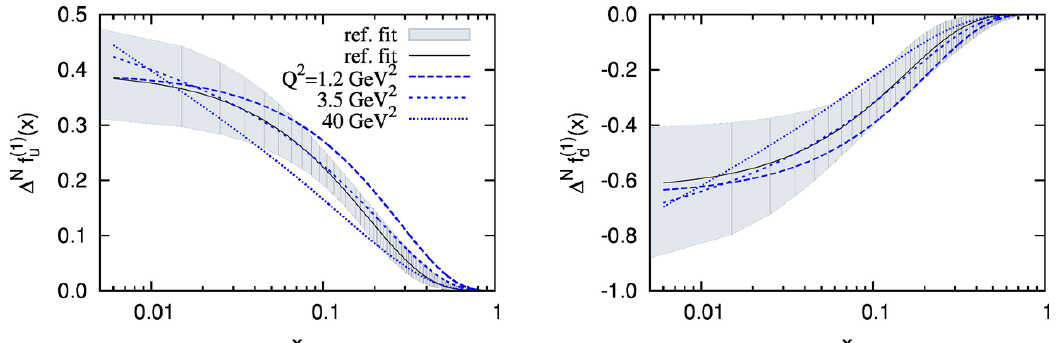
Figure 11 . Extracted (cid:12)rst moments of the Sivers function for u = u v +(cid:22) u (left panel) and d = d v + (cid:22) d (right panel). The results corresponding to the reference (cid:12)t with no Q 2 evolution (solid, black line) are compared to those obtained by applying a collinear twist-3 evolution (blue lines), as described in the text, for three values of Q 2 : 1 : 2 GeV 2 (long-dashed), 3 : 5 GeV 2 (short-dashed) and 40 GeV 2 (dotted). The bands correspond to the reference (cid:12)t with no Q 2 evolution.